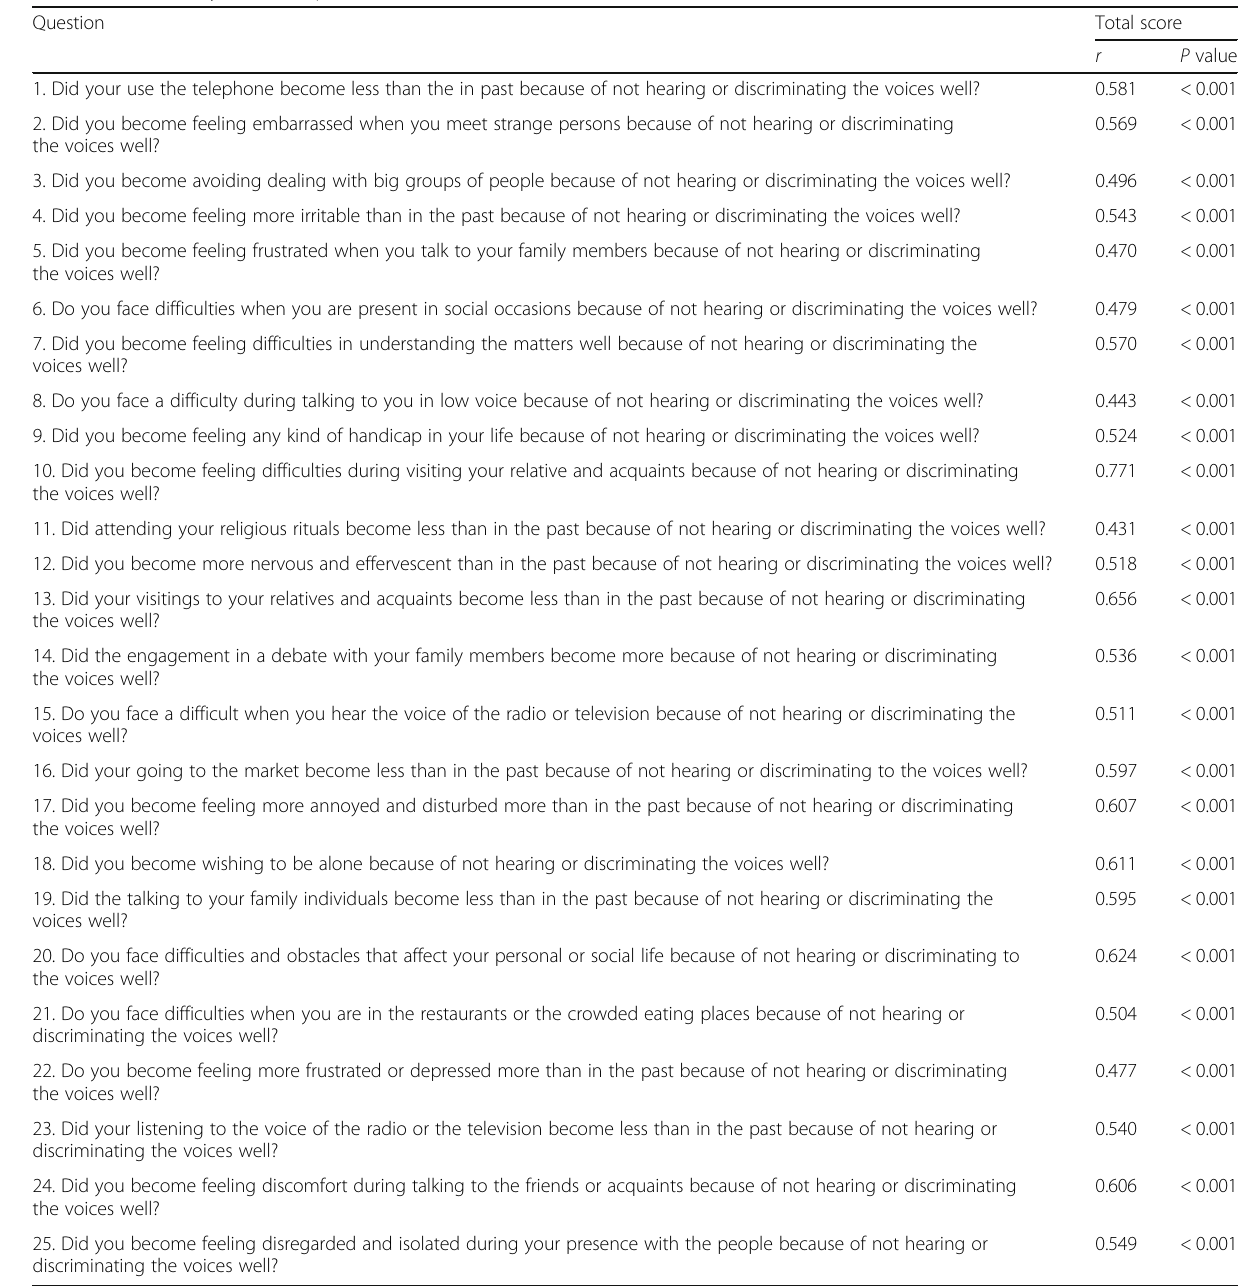
Table 4 Consistency for each question: r score and P value